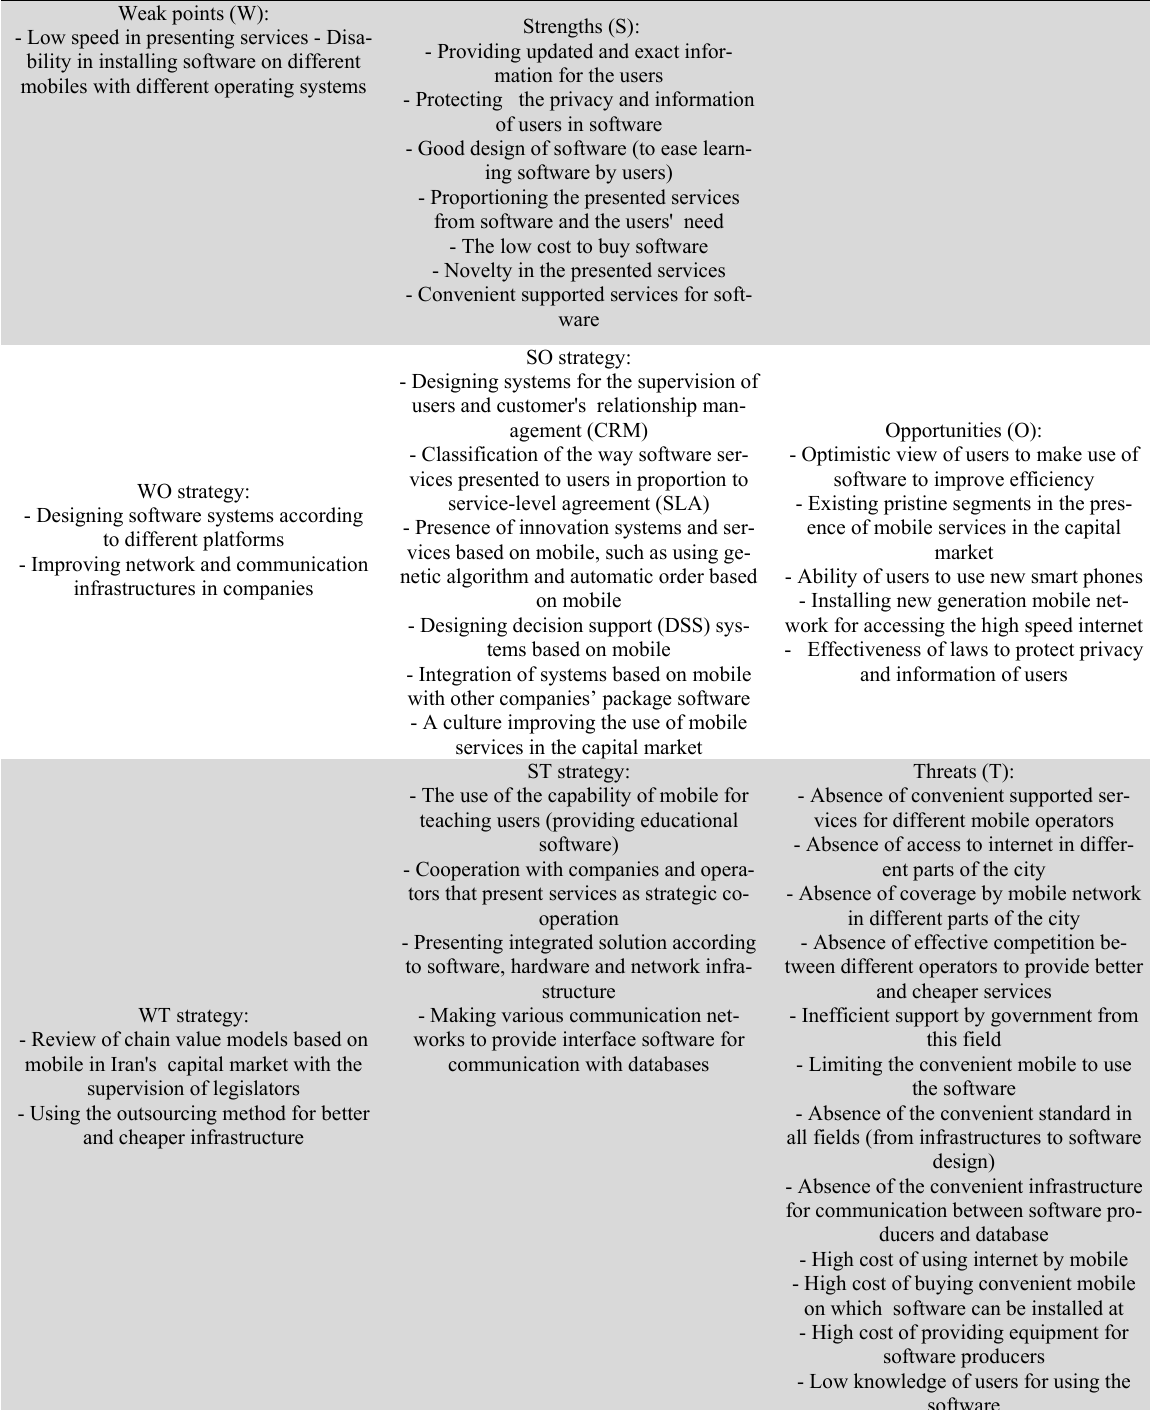
Strengths (S): - Providing updated and exact infor- mation for the users - Protecting the privacy and